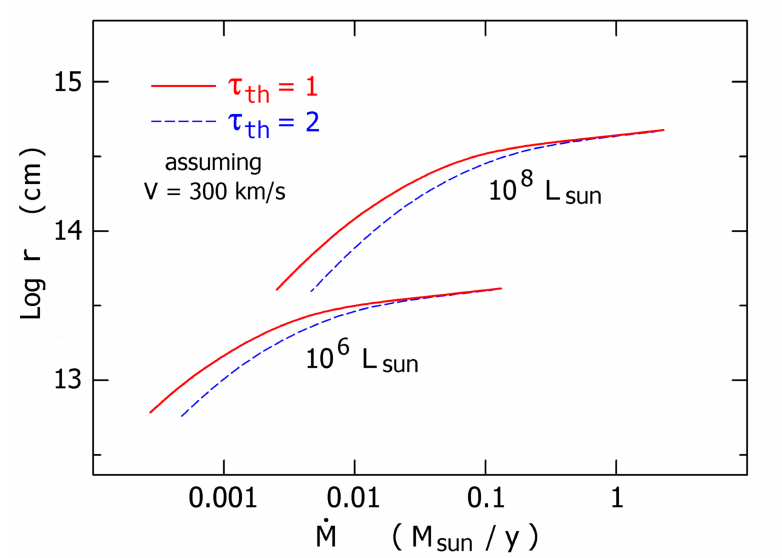
Figure 5. Radii of the photospheric locations shown in Figure 4. For large ˙ M the photosphere becomes geometrically thin (small ∆ r / r ) and thus resembles a plane-parallel